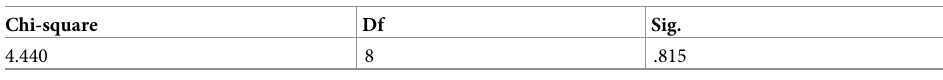
Table 7. Hosmer and Lemeshow